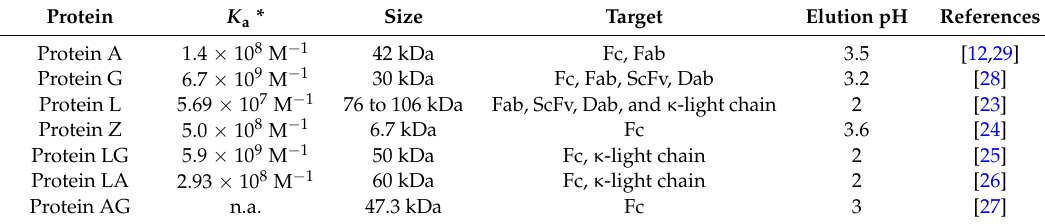
Table 1. General properties of the most used bacterial (fusion) proteins.